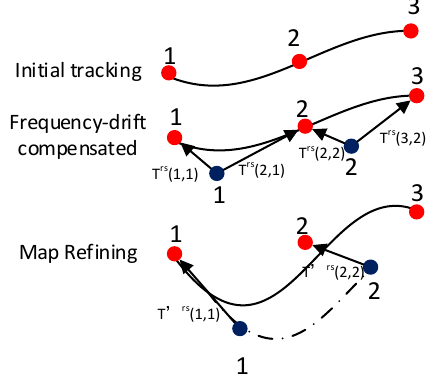
Figure 4. Framework for multiple camera